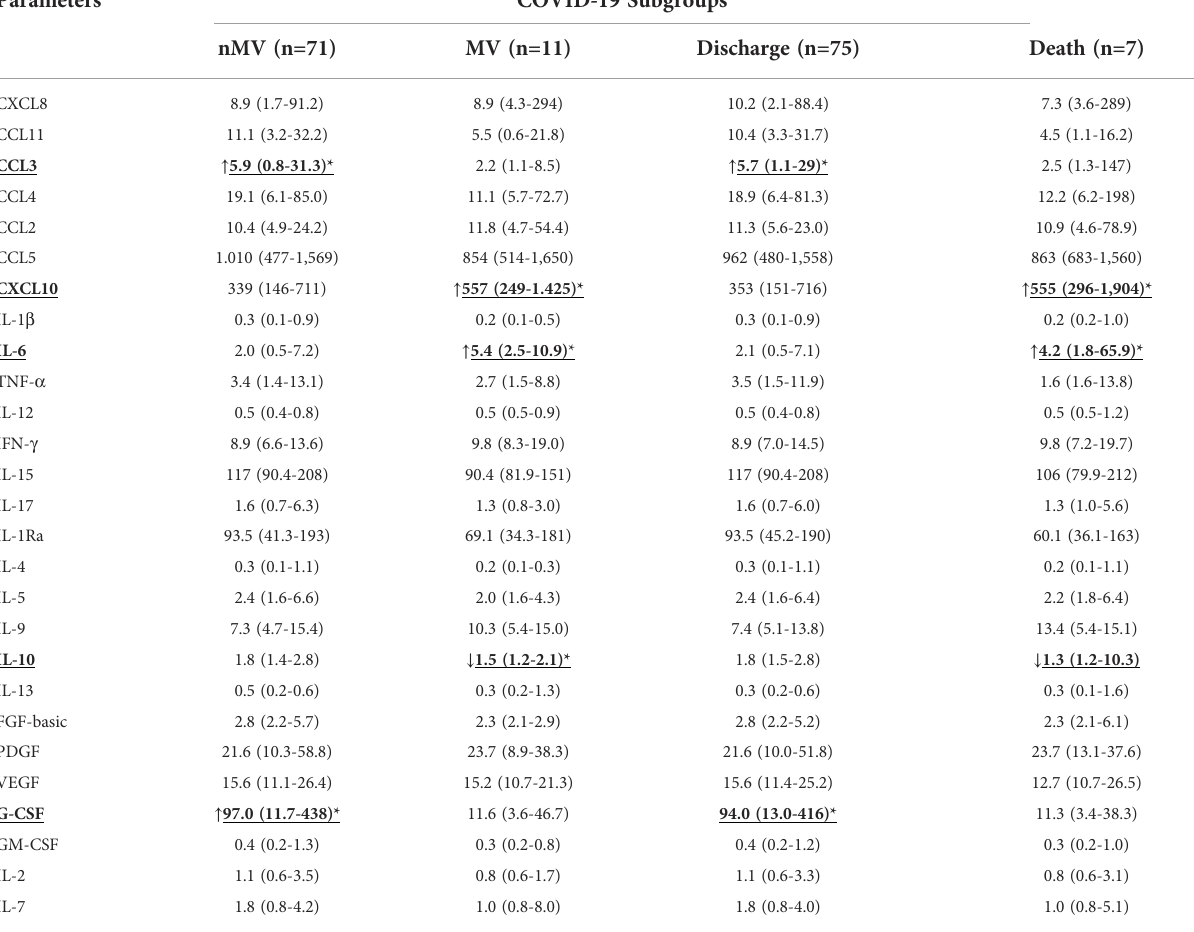
TABLE 1 Panoramic pro fi le of serum soluble mediators measured on hospital admission (D0) in SEVERE COVID-19 patients according to disease outcome.